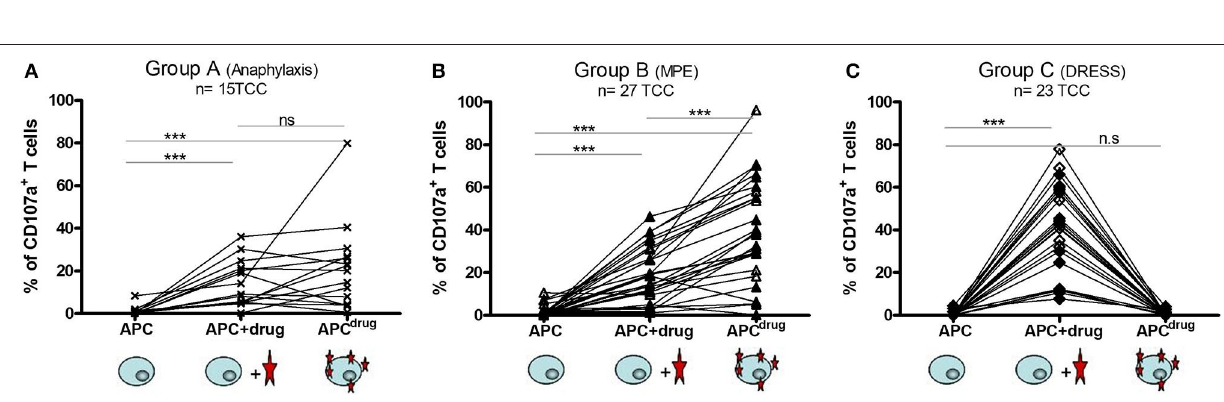
Frontiers in Allergy |